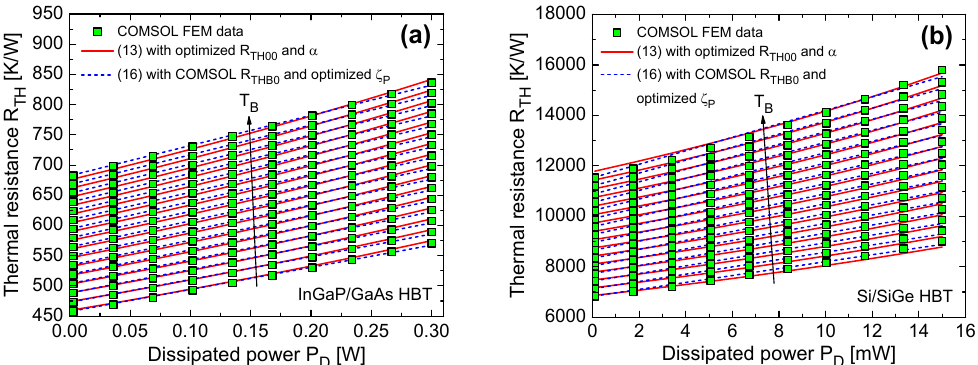
Figure 6. R TH vs. P D with T B spanning the range 300 to 450 K for ( a ) the InGaP/GaAs HBT and ( b ) the Si/SiGe HBT. COMSOL data (symbols) are compared with (13) where R TH 00 and α were optimized through a “brute-force 2-D search” carried out over all the simulated R TH values (solid red lines), and with (16) using the R THB 0 vs. T B values determined by COMSOL and ζ P calibrated at each T B (dashed blue lines).